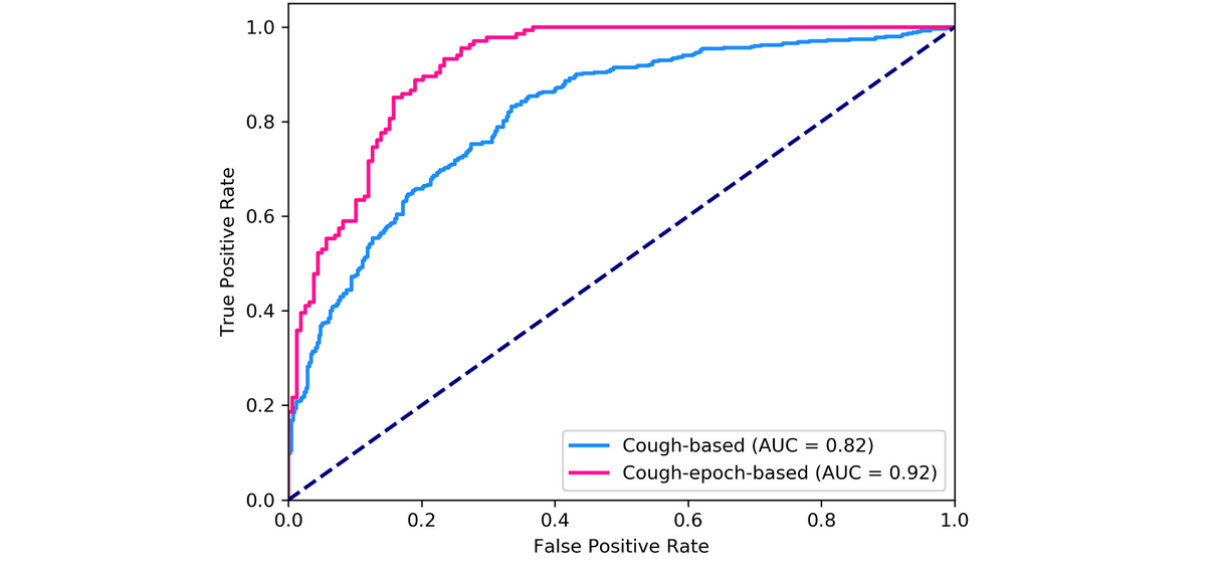
Figure 8. Receiver operating characteristic curves with corresponding area-under-the-curve values for cough and cough epoch–based sex assignment. The dashed line represents the curve for a random classifier. AUC: area under the curve; ROC: receiver operating